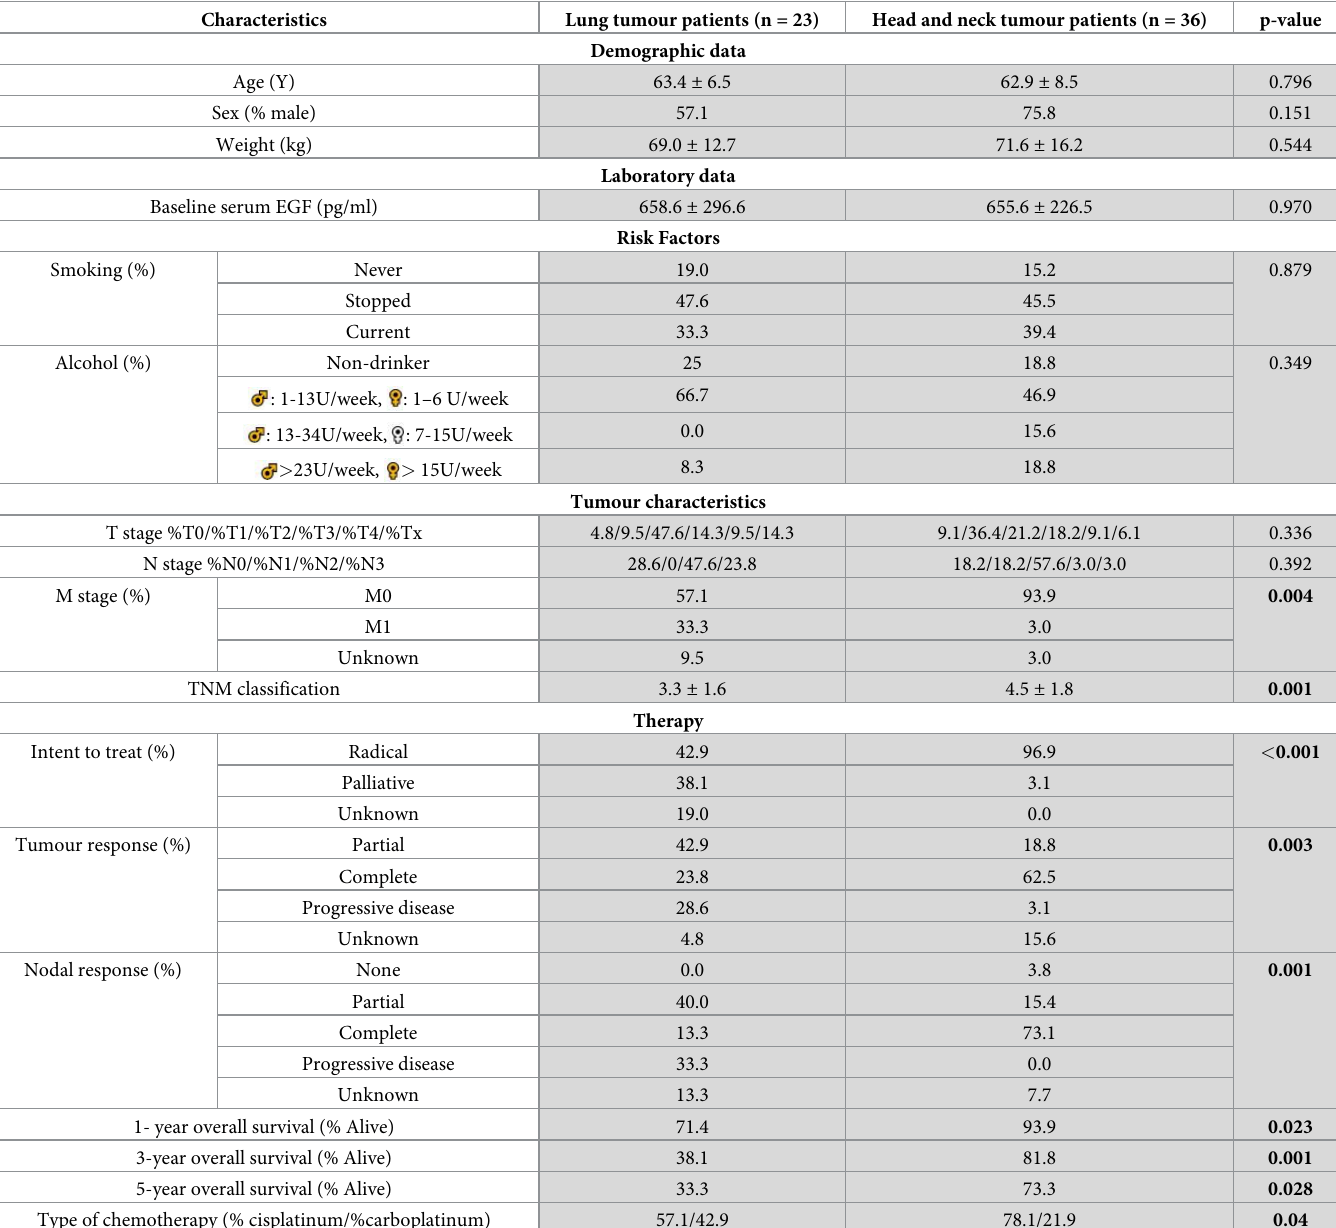
Table 1. Comparison of patient and tumour characteristics between lung tumour patients and head and neck tumour patients.